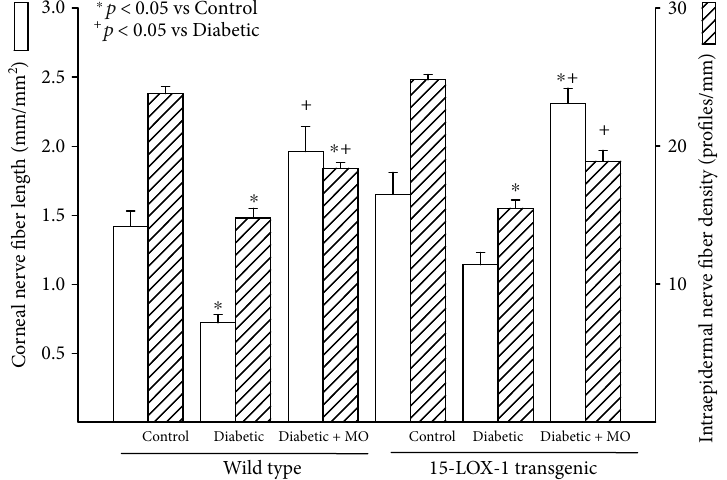
Figure 4: Treatment with menhaden oil of type 2 diabetic wild-type and 15-LOX-1 transgenic mice: e ff ect on corneal nerve fi ber length and intraepidermal density. Corneal nerve fi ber length and intraepidermal nerve fi ber density were examined as described in Section 2. The number of mice in each group was the same as described in Table 1. Data are presented as the mean ± SEM in mm/mm 2 and pro fi les/mm for corneal nerve fi ber length and intraepidermal nerve fi ber density, respectively. ∗ p < 0 : 05 compared to their respective control mice; + p < 0 : 05 compared to respective untreated diabetic